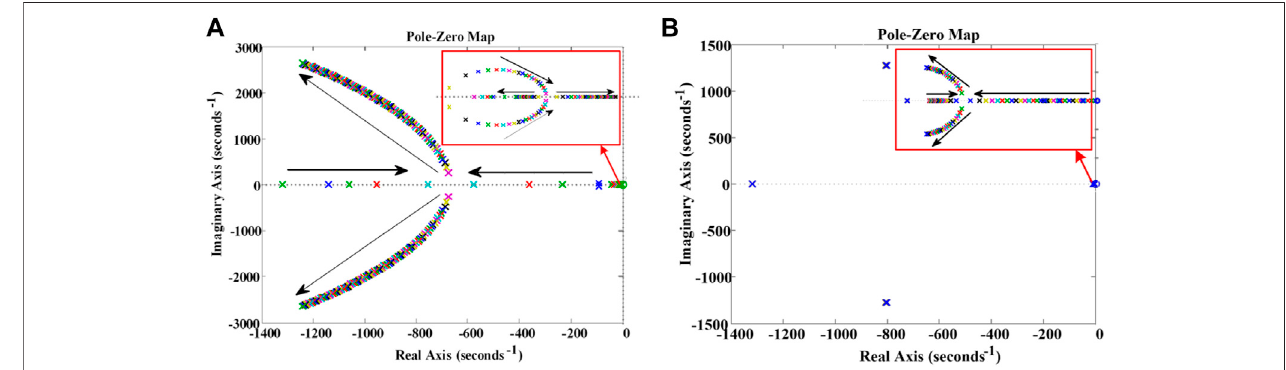
FIGURE 9 | Closed-loop pole distribution of voltage outer loop PI parameters: (A) The scale parameter k vp increases from 0.1 to 20; (B) The integral parameter k vi increases from 0.1 to 50).